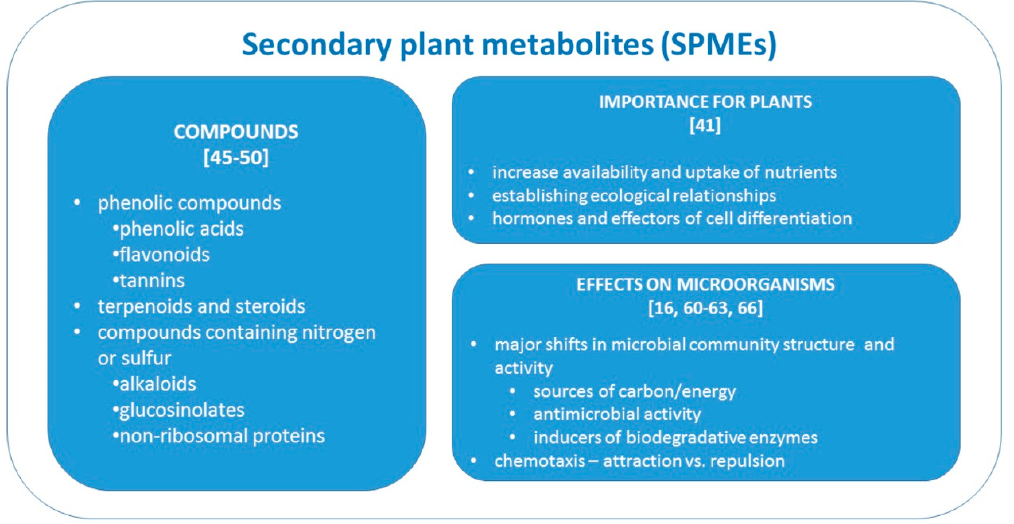
Figure 2. General overview of SPME classification and